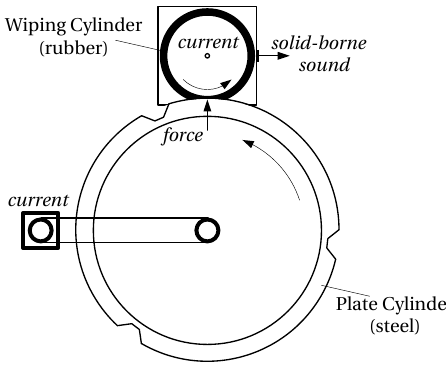
Figure 4. Structural design of the printing unit simulator along with the applied sensors (printed in italic)